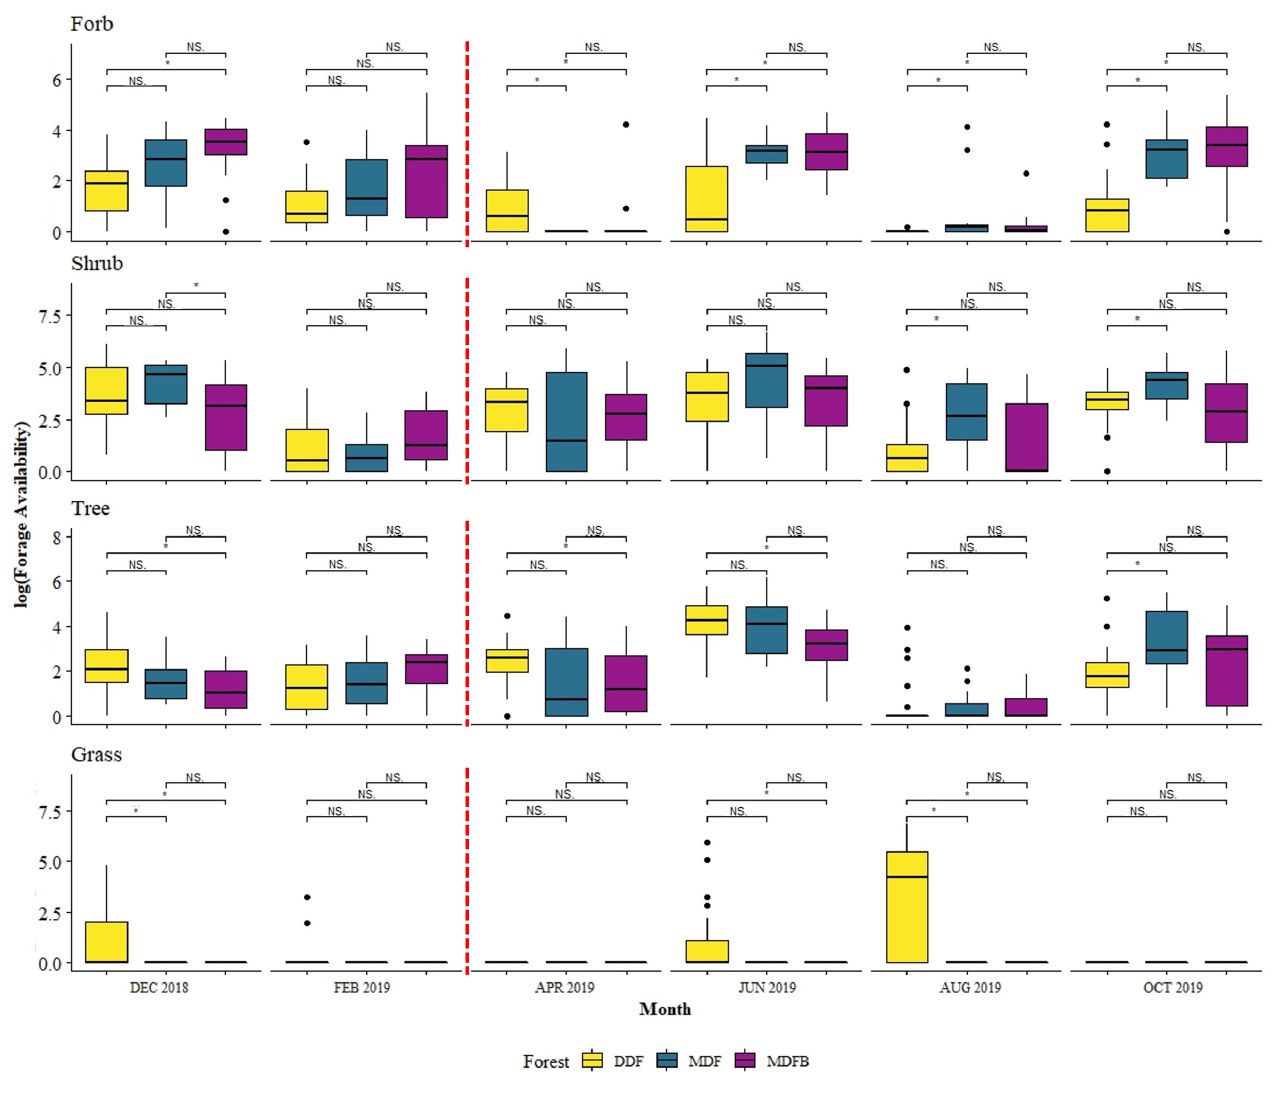
Figure 5. Forage availability for the different life forms and forest types over six sampling times. The dashed vertical red line shows the period of prescribed burning (22 February to 31 March 2019). The black dots represents data points that are beyond the 1.5 times of interquartile range (IQR) away from the mean. The asterisks (*) indicate a significant difference, and “NS” indicate a non-significant difference from the pairwise comparison with the Wilcoxon rank-sum